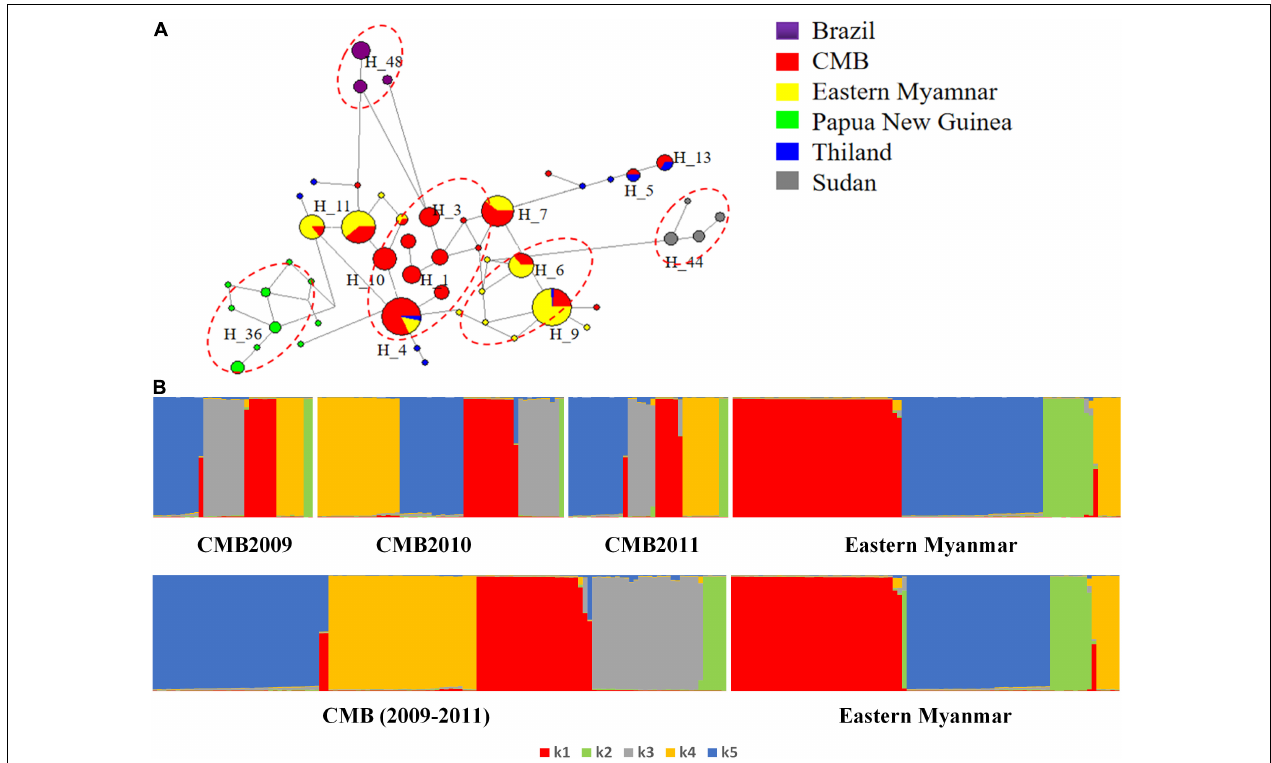
FIGURE 5 | STRUCTURE and Network analysis of PvDBP-II haplotypes. (A) The haplotype network shows the relationships among 50 haplotypes present in sequences of 260 isolates. (B) STRUCTURE analysis of the full set of variation loci from all isolates. Cluster for each isolate was assessed to an optimized cluster value of K =